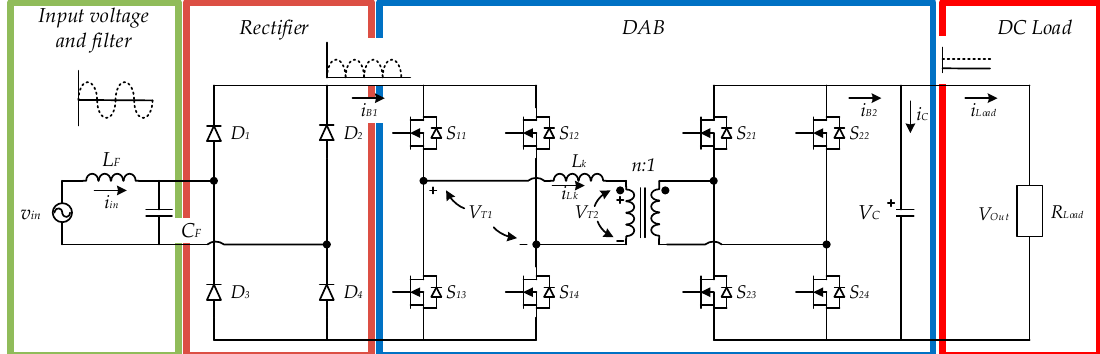
Figure 4. Proposed AC–DC DAB system.